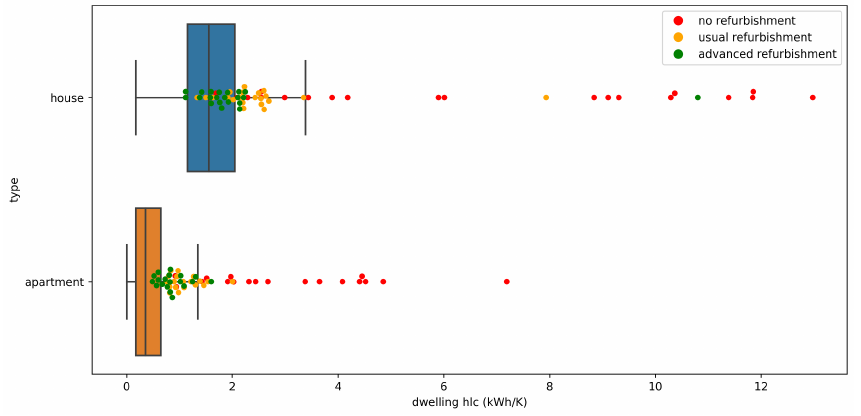
Figure 16. hlc comparisons between TABULA average buildings and inferred values (dwelling types model).